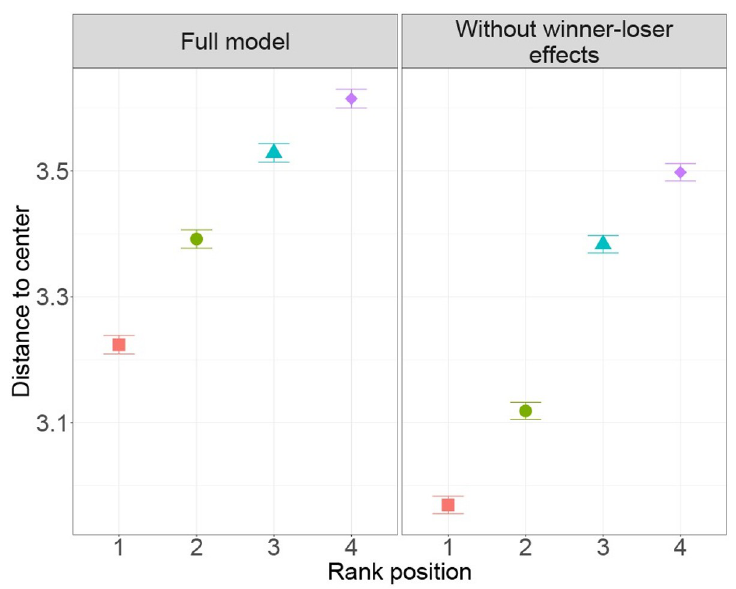
Table 3. Comparison between patterns of hierarchical development in the full model DomWorld and in groups of hens [21]. Measure DomWorld Hens